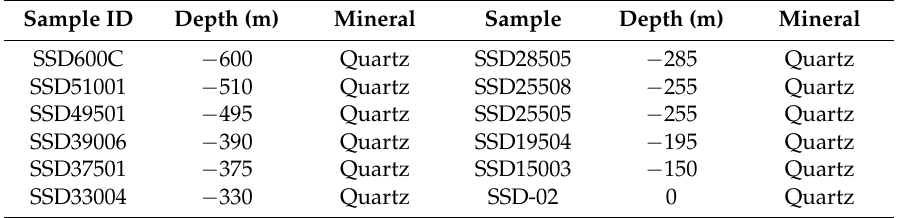
Table 1. Samples for microthermometry in the Sanshandao gold deposit.